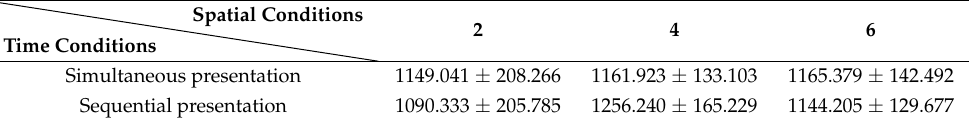
Table 4. Tracking reaction time t/ms (M ± SD, N = 33).